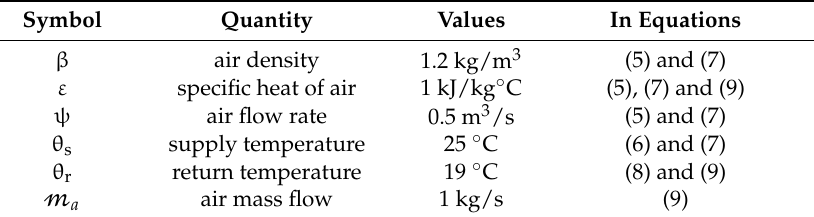
Table 1. The considered parameters of domestic heat pumps (DHPs).